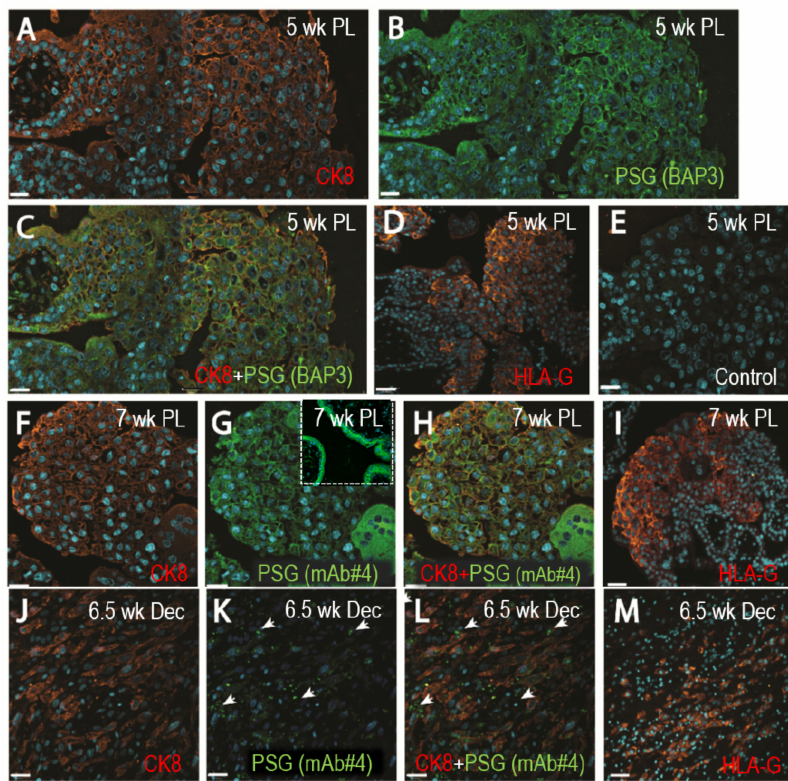
Figure 1. Pregnancy-specific glycoproteins (PSGs) localize to extravillous trophoblasts (EVTs) in first-trimester placenta and interstitial EVTs in the decidua. Representative photographs of dual fluorescent immunohistochemistry localizing cytokeratin 8 (red) and PSGs (green with both BAP3 and #4 mAbs) are shown in both individual and dual channels in sections of first-trimester placenta and decidua basalis. Serial sections stained with a mAb against HLA-G are shown in ( D ), ( I ) and ( M ) (red) to confirm localization in the EVTs. ( A – E ) 5-week old placenta. A : CK8, B : PSG (BAP3), C : CK8 and PSG (BAP3), D : HLA-G and E : guinea pig and mouse IgG control. ( F – I ) 7-week old placenta. F